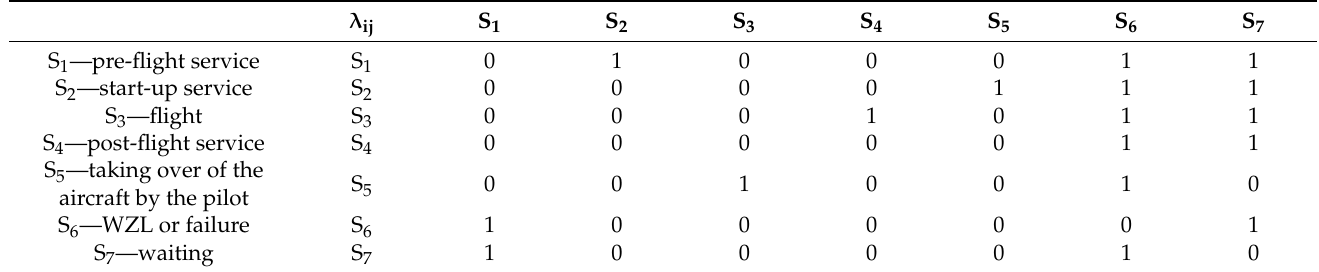
Table 1. The possibility of transitions between certain states (own study).